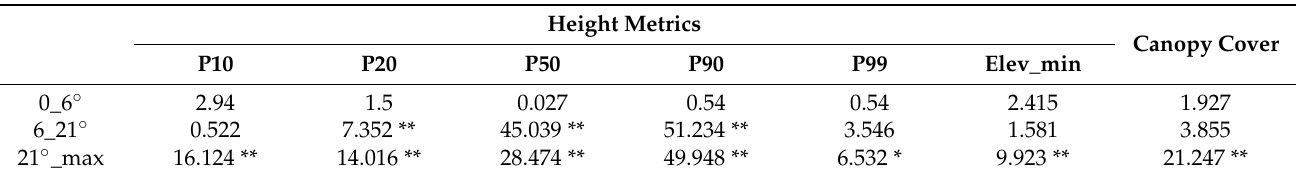
Table 6. KW test of coniferous and broadleaf forests for stratified density variables from LiDAR data at different scanning angles.